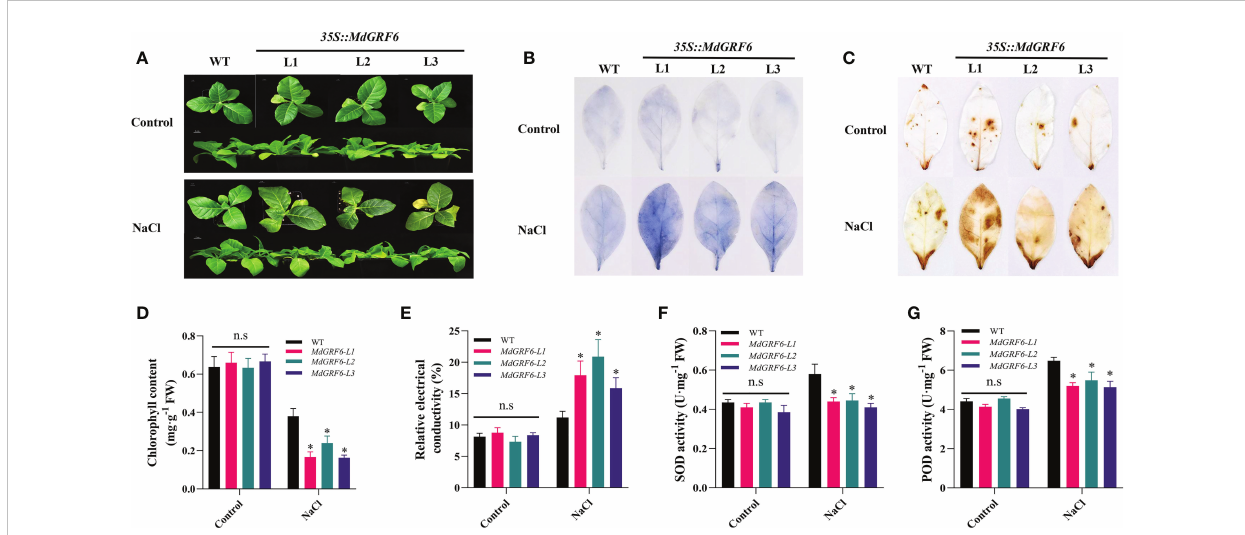
FIGURE 6 Effects of salt on the growth of germinated WT and 35S::MdGRF6 transgenic tobacco plants. (A) The phenotype of WT and three transgenic tobacco lines under salinity stress conditions. (B, C) Following salt stress treatments, leaves from MdGRF6 transgenic lines and WT were stained for H 2 O 2 using DAB staining and for O · − 2 using NBT staining. Statistical analysis of (D) chlorophyll content, (E) electrical conductivity, (F) SOD activity, and (G) POD activity in WT and transgenic lines after salt treatments. Error bars indicate the means ± SD (n = 3). The asterisks indicate signi fi cant